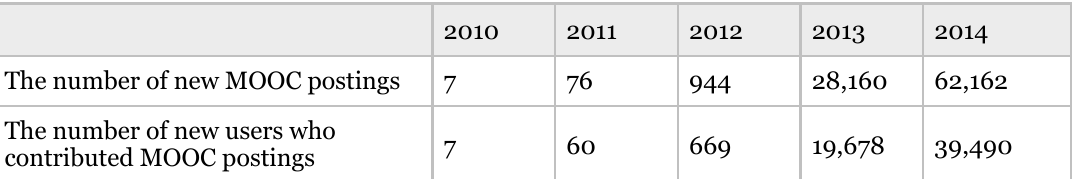
Table 1: MOOC postings on Sina Weibo: 2010-2015